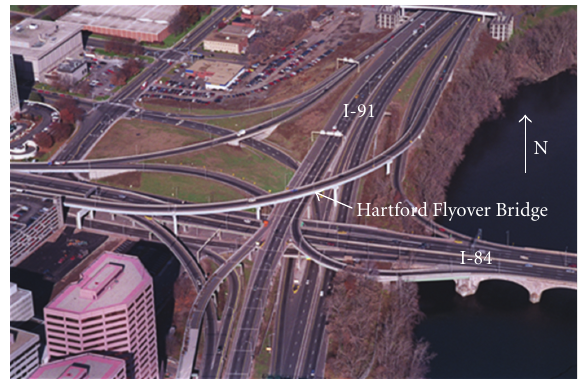
Figure 1: Aerial view of the Hartford Flyover